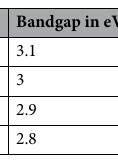
Table 4. Representative the values of bandgap of Cu–TiO 2 at different percentages 10, 20, 30, and 40 wt.% of